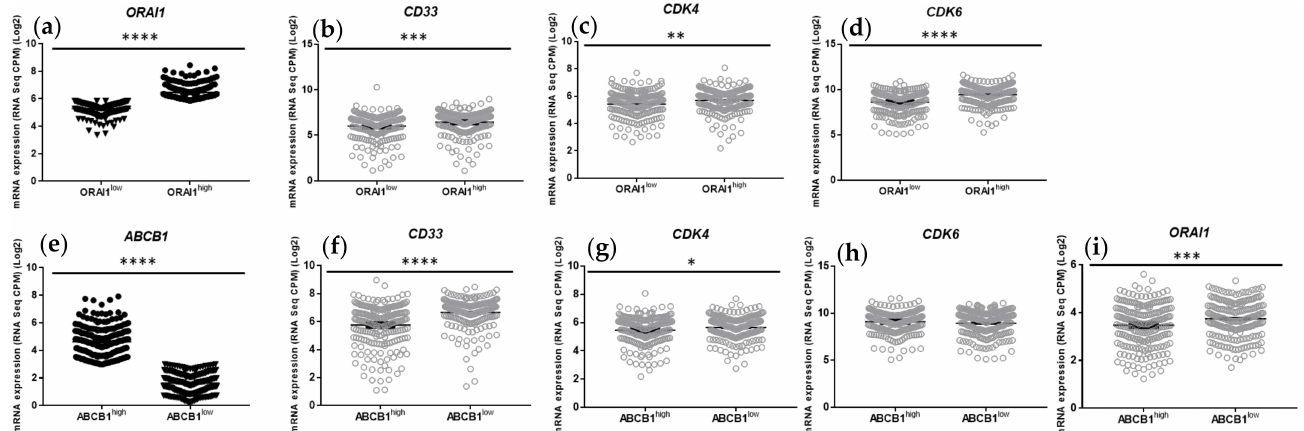
Figure 3. Expression of CD33, CDK4 and CDK6 in primary AML cells isolated from patients at the time of diagnosis, according to ABCB1 and ORAI gene expression. ( a – i ) RNA-seq data were generated by Tyner et al. [12] from samples derived from patients with AML. RNA-Seq data were obtained from public domain AML datasets (https://www.cbioportal.org). Data were extracted as described in [13,14] for ORAI1 and ABCB1 expression, and 2 groups ( n = 220 and n = 219) of AML patients were discriminated according to high or low levels of ORAI1 ( a ) and ABCB1 ( e ) expression. Data were extracted for CD33, CDK4 and CDK6 gene expression in the ORAI1 low and ORAI1 high AML and in the ABCB1 low and ABCB1 high AML patient subgroups. Normalized expression values are presented as CPM; p values were obtained from Student’s t tests between means (* p < 0.05; ** p < 0.01; *** p < 0.001; **** p <